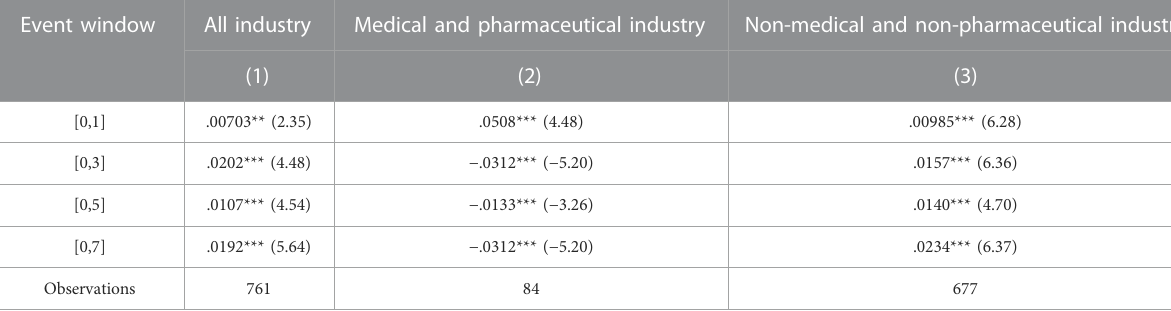
TABLE 3 The GEM ’ s respond to “ Good News ” (improving situation).